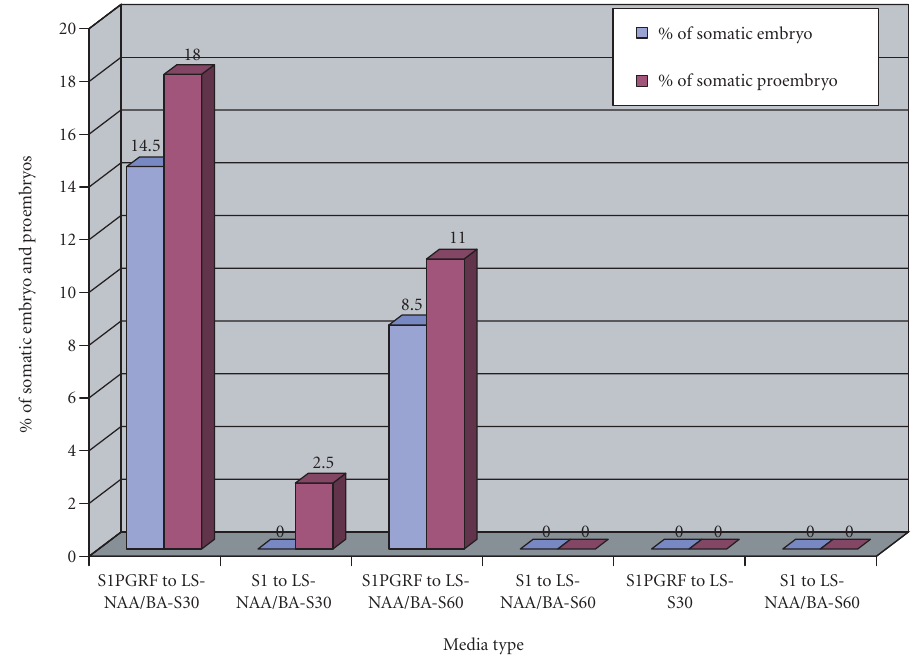
Figure 1: Somatic embryogenesis from a cell suspension of Papaver somniferum album cultivated on liquid media S1 (2,4-D 0.2mg/l and kinetin 0.1mg/l) and S1PGRF (plant growth regulators free). NAA, naphtaleneacetic acid; BA, benzyladenine; LS, Linsmaier and Skoog